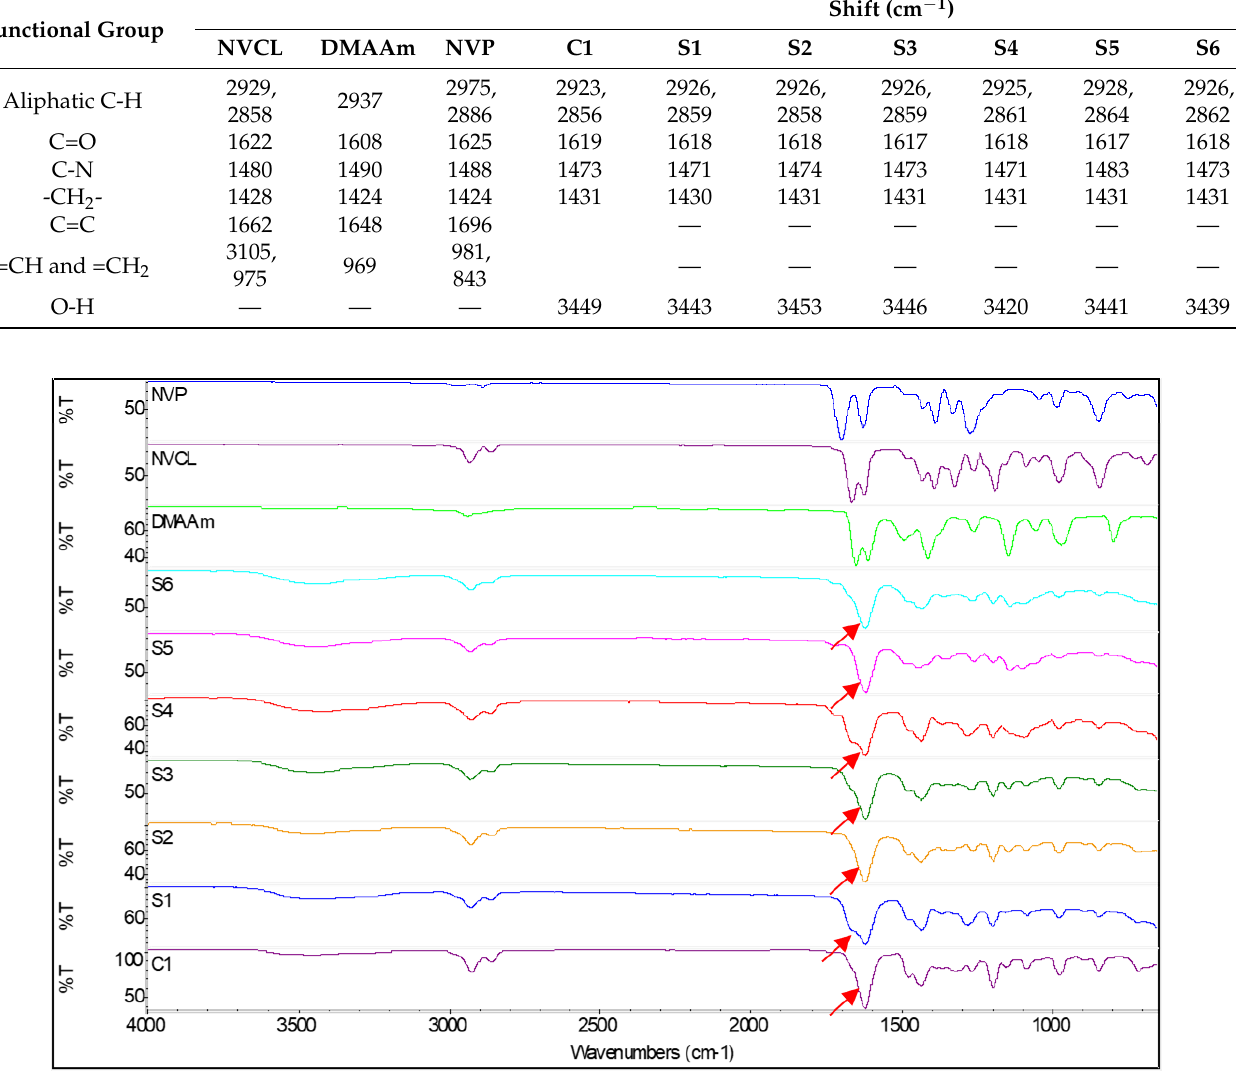
Table 3. FTIR bands for NVCL and novel synthesised copolymers.